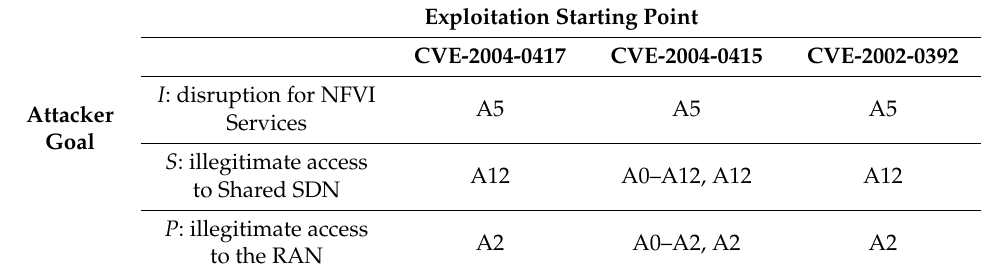
Table 2. Attacker Decision